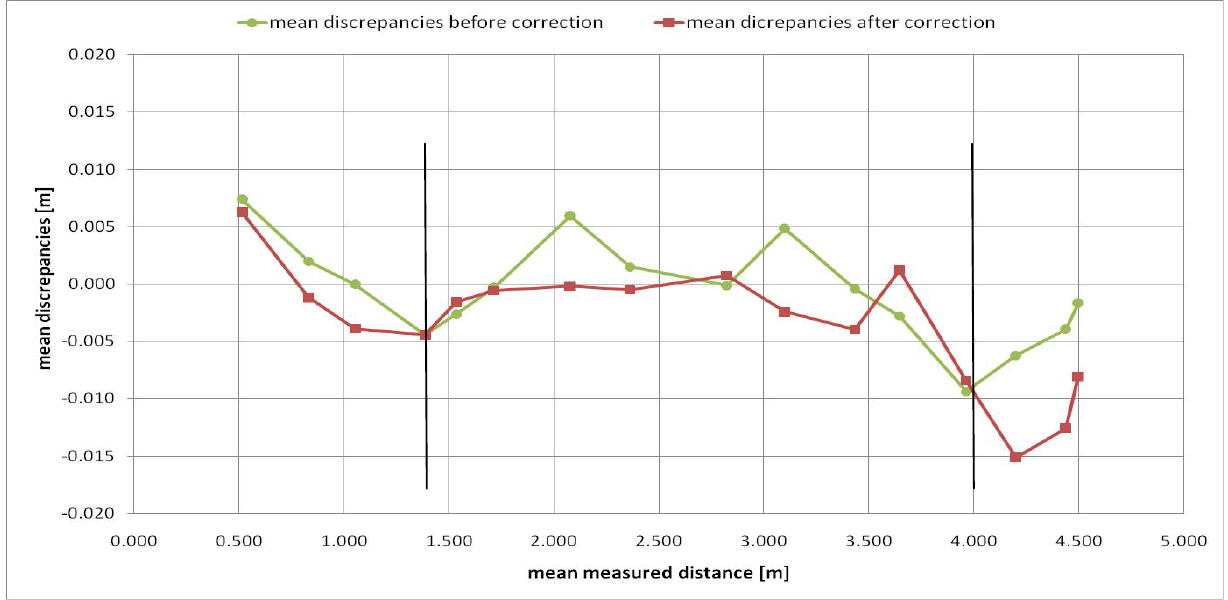
Figure 6. Mean values of the discrepancies ( g ) of all the considered pixels before and after distance error model